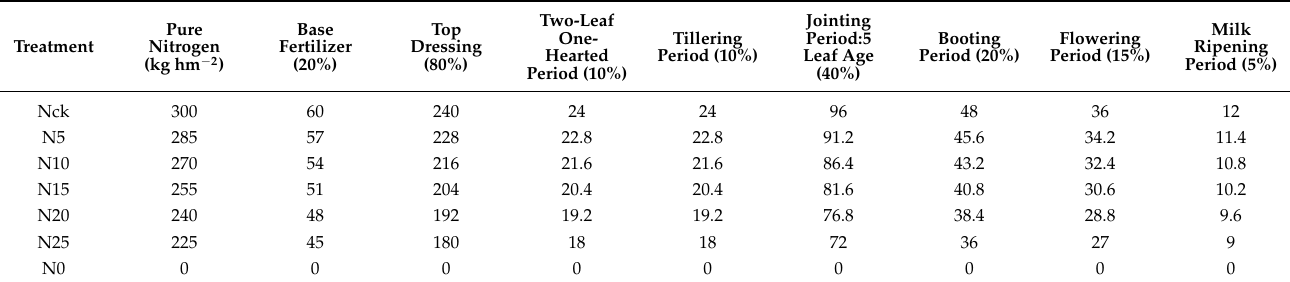
Table 1. Amount of nitrogen fertilizer in different treatments in 2018 and 2019.